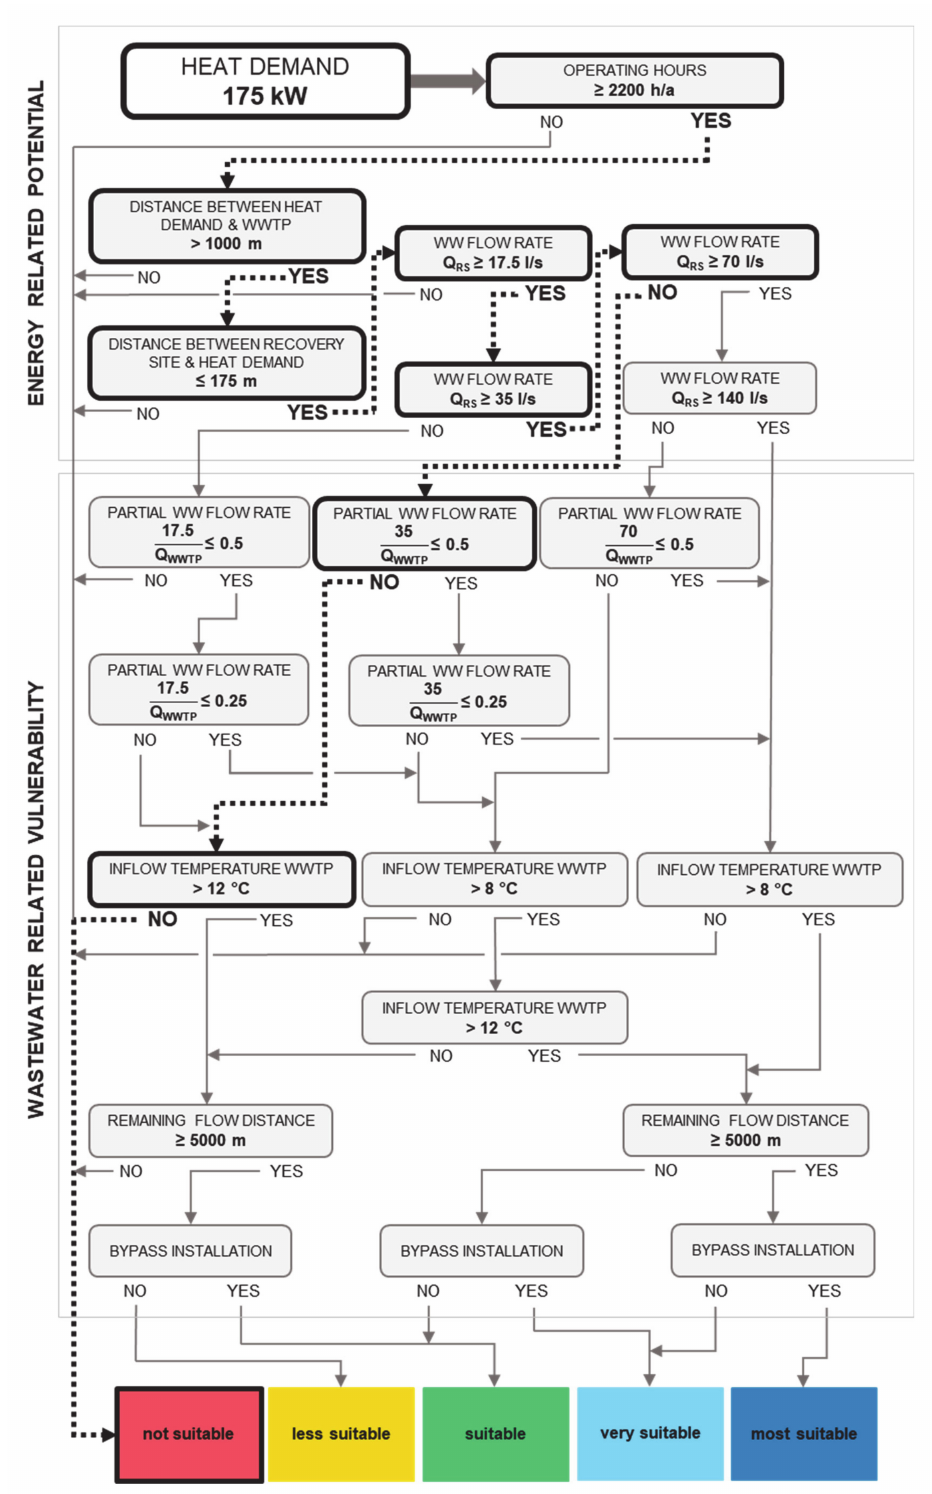
Figure 5. Pre-assessment process for heat recovery site M1 for an intended heat supply of 175 kW (own representation, based on